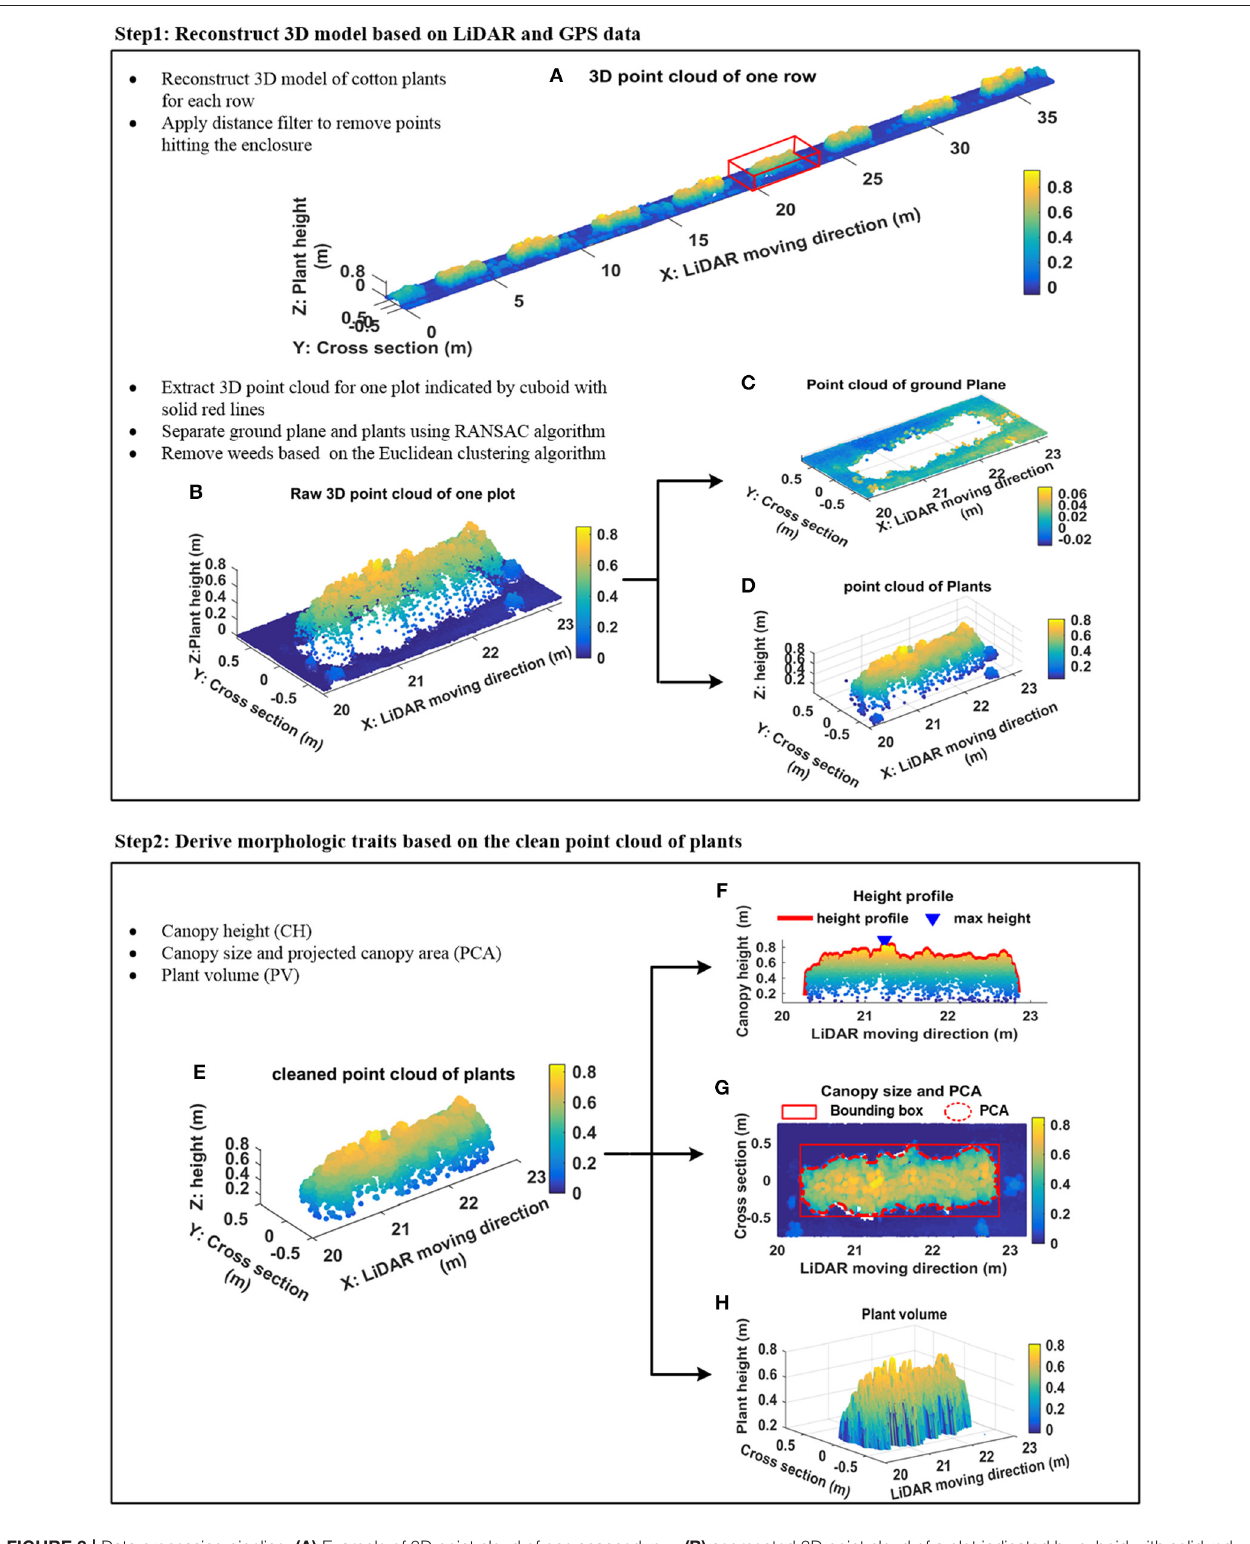
FIGURE 3 | Data processing pipeline. (A) Example of 3D point cloud of one scanned row; (B) segmented 3D point cloud of a plot indicated by cuboid with solid red lines in (A) ; (C) point cloud of ground plane; (D) point cloud of plants; (E) denoised point cloud of plants; (F) height profile of plants and maximum canopy height; (G) projected canopy area; (H) plant